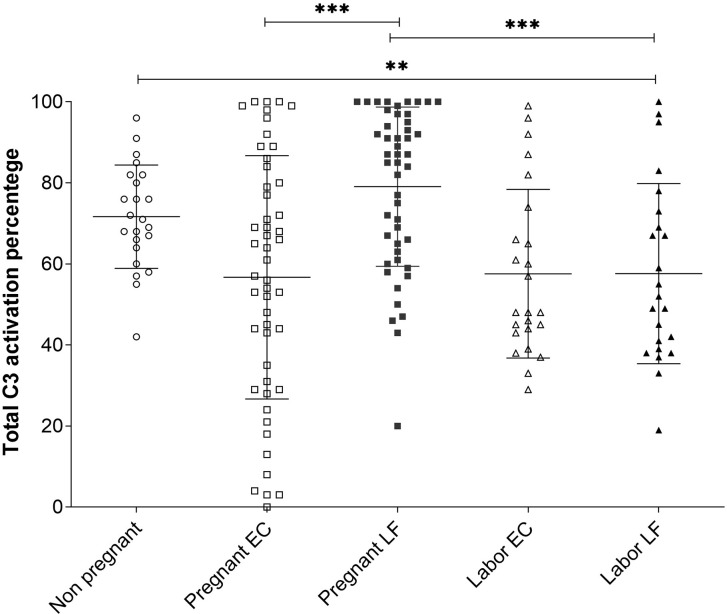
Comparison of C3 activation levels in samples from the EC and the LF in the 3 different groups. The percentages of C3 activation in the three groups were determined from the Western blot analysis of C3 split products using the “ImageJ” program. The mean ± SD values for the different groups were: nonpregnant women 72 ± 13% (n=23), pregnant women EC 57±30%, LF 79 ± 20% (n=49) and women in labor 58 ± 22% (n=24) in both the EC and LF. The differences were significant between women at labor vs. pregnant women (***, P < 0.001; for LF samples) or nonpregnant women (**, P<0.01) (Tukey’s Multiple Comparison Test). The C3 activation percentages in samples taken during pregnancy were significantly higher in the LF (79 ± 20%; n=49) than in the EC (57 ± 30%; n=49); (***, P < 0.001). No difference between LF and EC in samples taken at labor were seen.